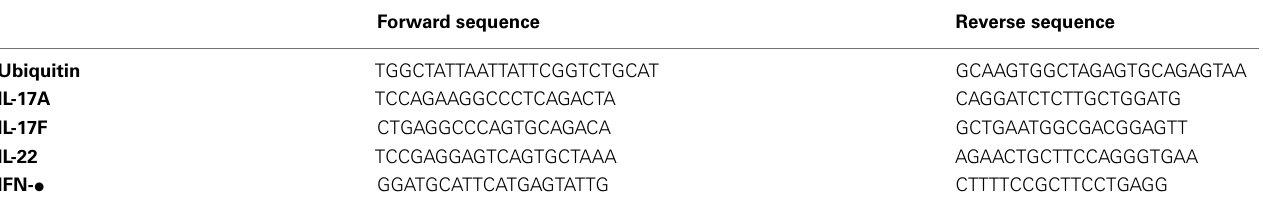
TableA1 | Primers used for Real-time quantitative PCR